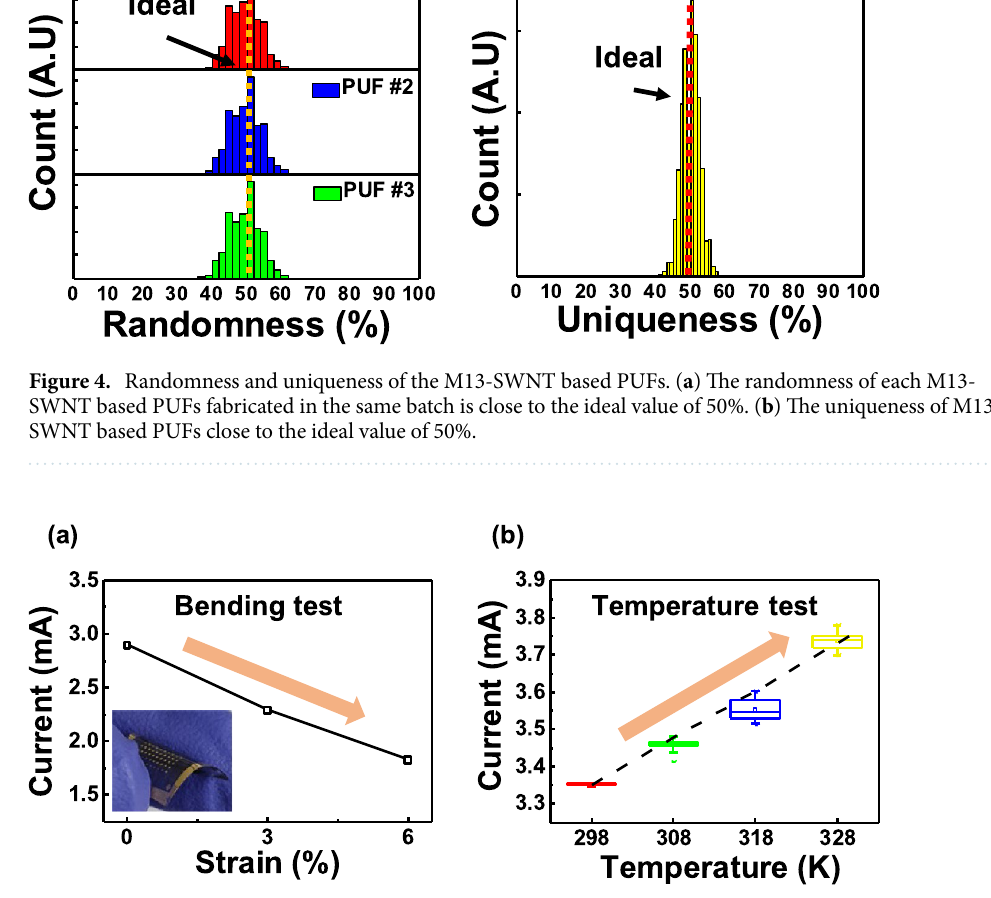
Figure 5. Resistance variations of the M13-SWNT based PUFs caused by environmental variations. ( a ) Explicit negative relation between the current and the bending strain on the substrate and ( b ) positive tendency of the current to the temperature